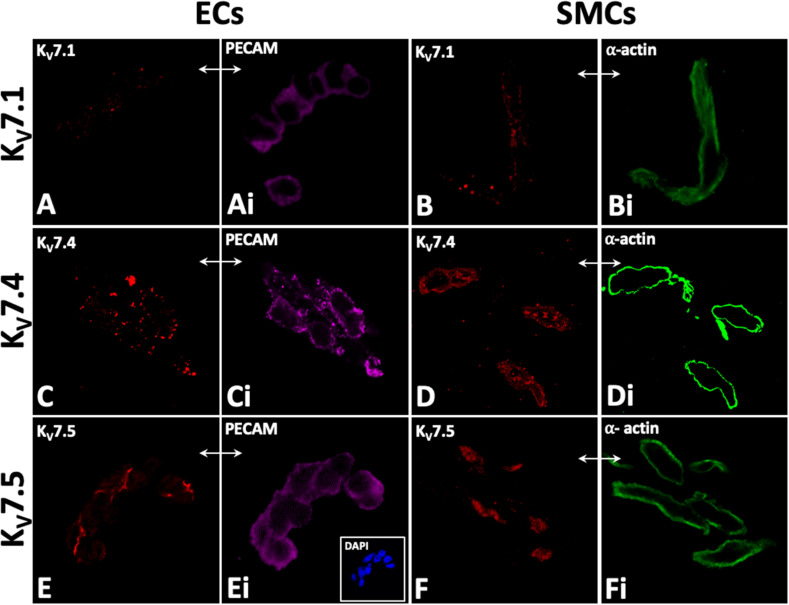
Immunocytochemistry demonstrates KV7.1, KV7.4, and 7V.5 localization in rat mesenteric artery isolated endothelial (EC; A,C,E) and smooth muscle cells (SMC; B,D,F). Punctate labelling for Kv7.1, Kv7.4, and 7.5 was present in isolated EC and SMCs (A,C,E and B,D,F). PECAM and smooth muscle a-actin were used as markers for isolated endothelial and smooth muscle cells, respectively (Ai,Ci,Ei and Bi,Di,Fi respectively); e.g. comparative-same cells, double arrows, A–Fi). 4′,6-diamidino-2-phenylindole (DAPI; e.g. inset, C) were used as nuclear markers to verify cell patency. n = 4–6, representative of different source tissue (A–Fi). Double arrows from insets indicate same panel as main, but to different marker.